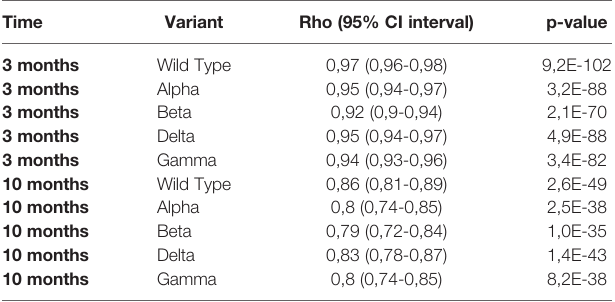
TABLE 2 | Spearman rank correlation of %inhibition for WT and the four VOC with IgG anti-S. Time